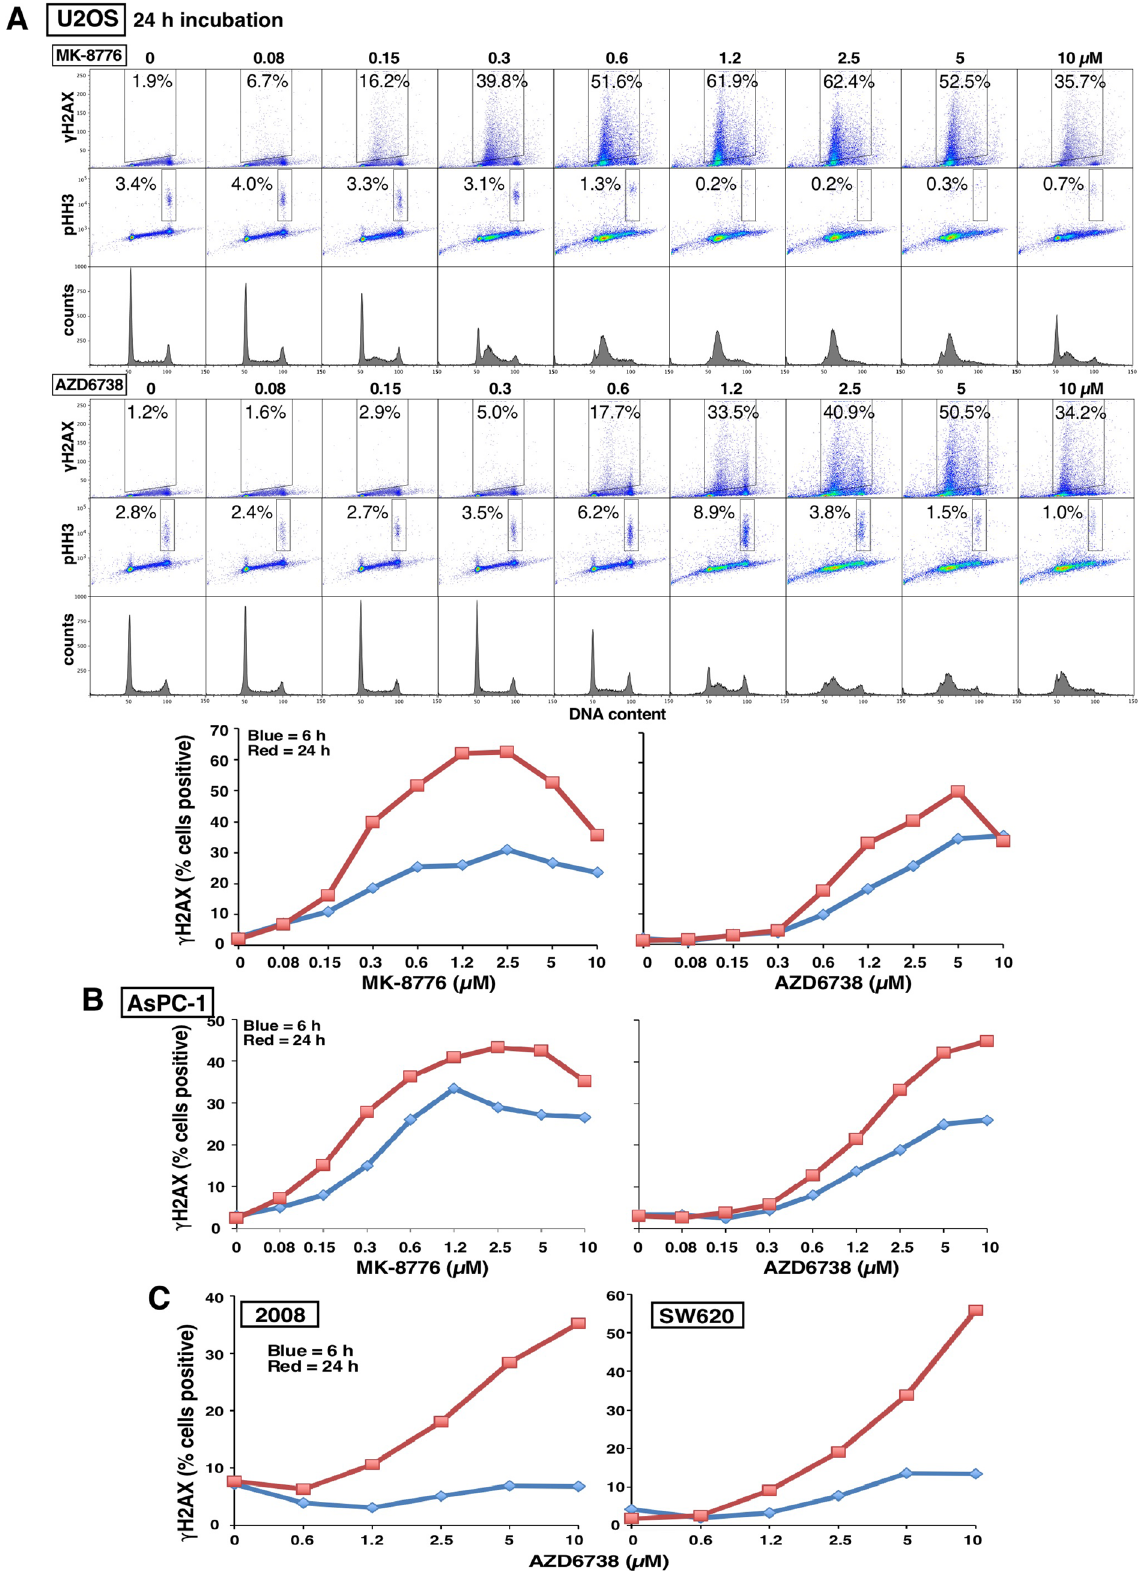
Figure 2. Induction of γH2AX by MK-8776 and AZD6738 in U2OS and AsPC-1 cells. ( A ) U2OS cells were incubated with the indicated concentrations of MK-8776 (upper panel) or AZD6738 (lower panel) for 6 h (not shown) or 24 h, then fixed and analyzed by flow cytometry for DNA content, γH2AX and pHH3. The percentage of cells positive for γH2AX or pHH3 is shown, and the results for γH2AX-positive cells are graphed. ( B ) ASPC-1 cells were incubated with MK-8776 and AZD6738 and analyzed by flow cytometry as in A. ( C ) 2008 and SW620 cells were incubated with AZD6738 for 6 or 24 h and analyzed as in A. The original data for panels B and C are presented in Supplementary Fig.